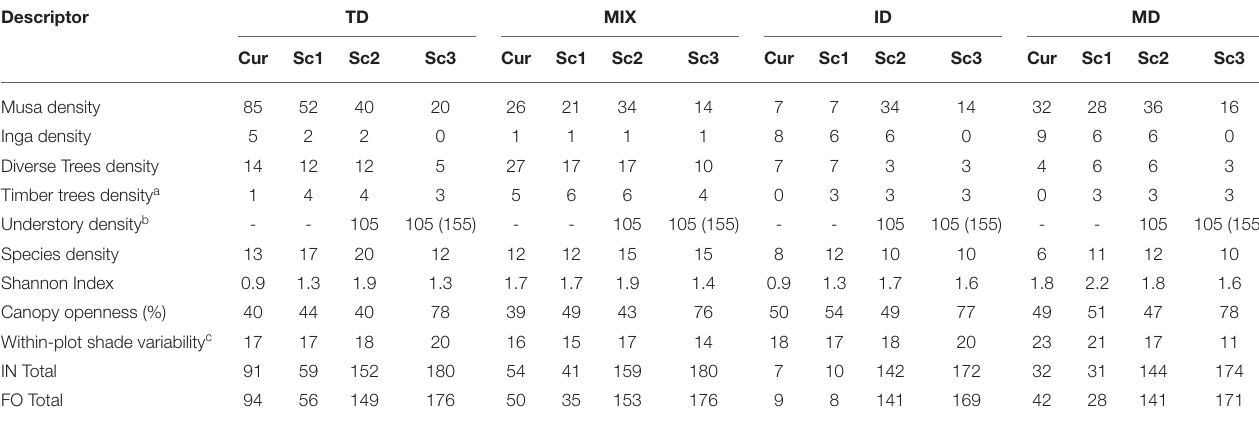
Cur, current situation; Sc1, timber with habitat; Sc2, agroforestry for zero-grazed ruminants; Sc3, rotational gap for system renewal. a Timber trees included Cedrela, Juglans, Bombacopsis, Nectrandra, Platymiscium, and